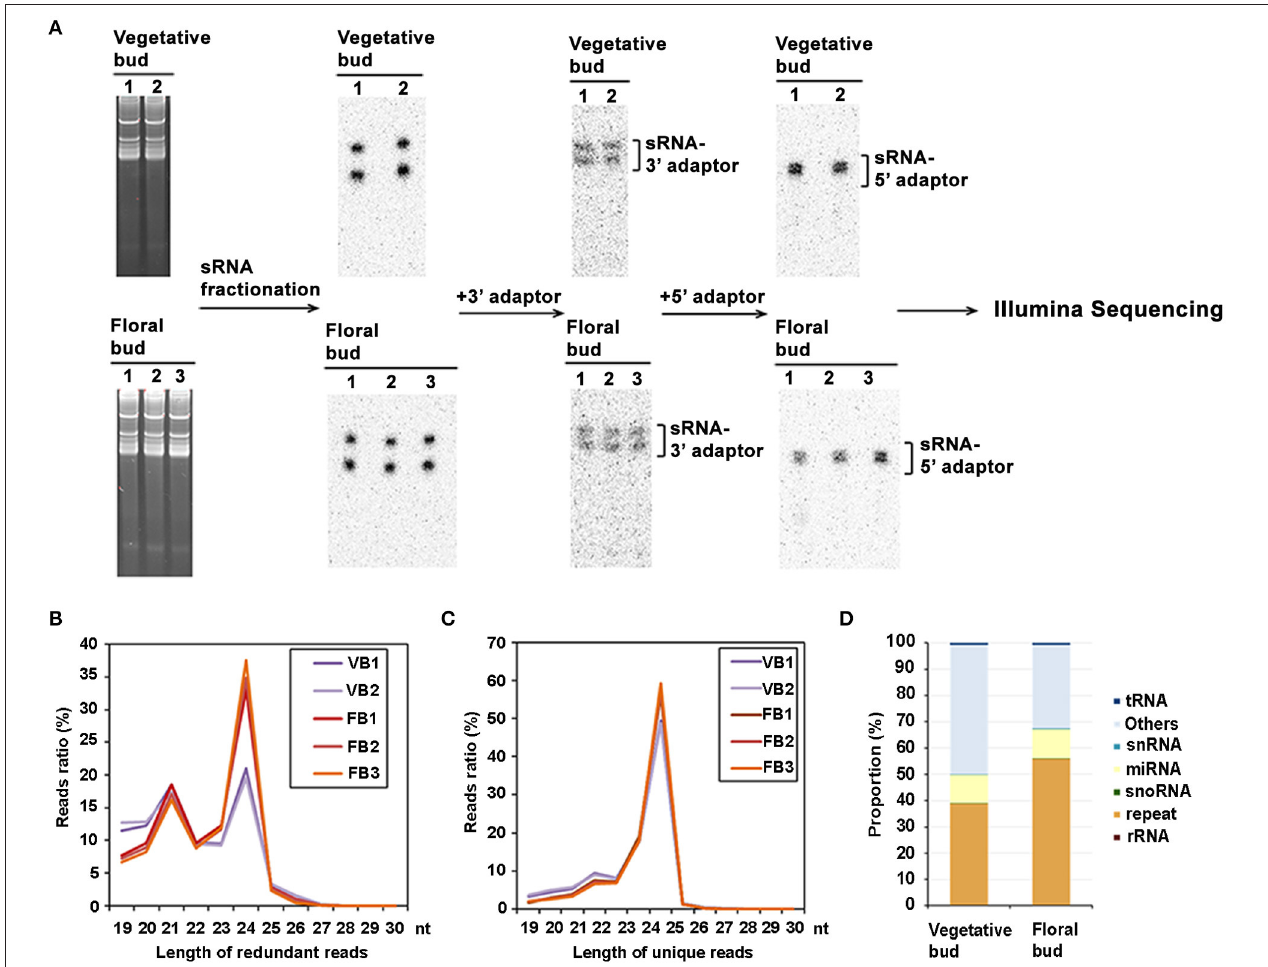
FIGURE 1 | Cloning of sRNAs from vegetative and floral bud in Malus domestica. (A) RNA extraction and cloning of sRNA from vegetative and floral bud. (B,C) Size distribution of redundant (B) and unique (C) reads of sRNAs from vegetative and floral bud. (D) Genomic features of sRNA prepared from vegetative and floral bud.